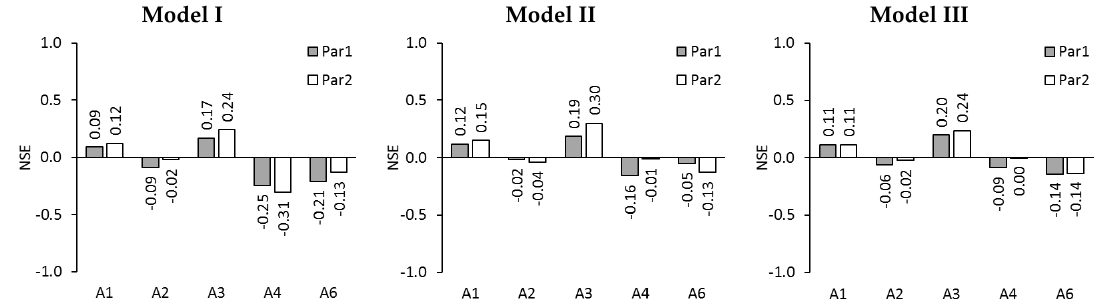
Figure 4. NSE for permeate fluxes of test series A1, A2, A3, A4, and A6 simulated with Model I, Model II, and Model III using membrane parameter set Par1 and Par2.